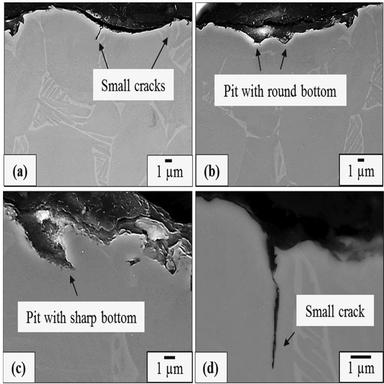
Early stage rain erosion damage: (a) and (b) taken from L3 zone of blade leading edge; (c) and (d) taken from L3 zone of blade leading edge.